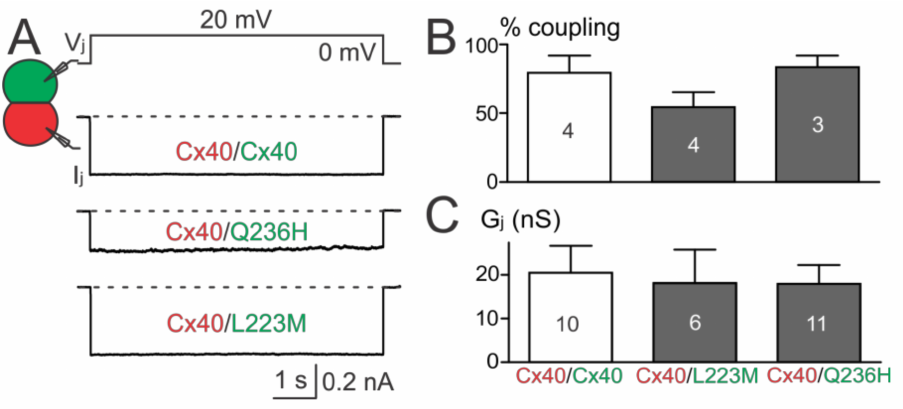
Figure 6. Functional test on heterotypic mutant/Cx40 GJs. ( A ) I j s were obtained from heterotypic Q236H/Cx40, L223M/Cx40, or Cx40/Cx40 (in all cases with untagged GFP or DsRed, respectively) N2A cell pairs; ( B ) Bar graph summarizes the coupling percentages of heterotypic cell pairs. No statistical difference was found between the coupling percentage of any of the mutant heterotypic GJs and that of Cx40/Cx40 GJs. The number of transfections is indicated; ( C ) G j s of cell pairs expressing L223M/Cx40 or Q236H/Cx40 were not statistically different from those of Cx40/Cx40. The number of cell pairs is